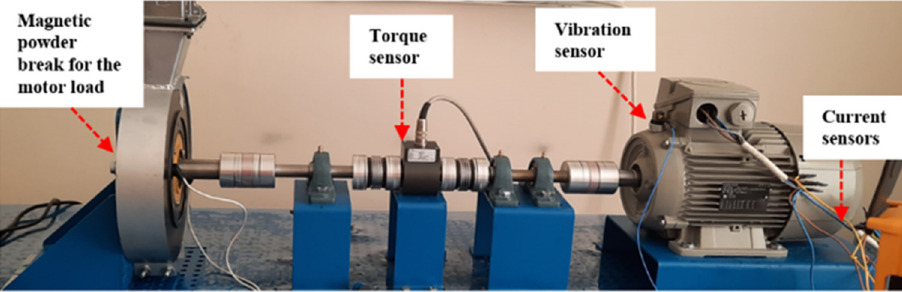
Figure 2. Electrical motor use-case test bed implemented for verification of the PdM platform for condition monitoring applications.